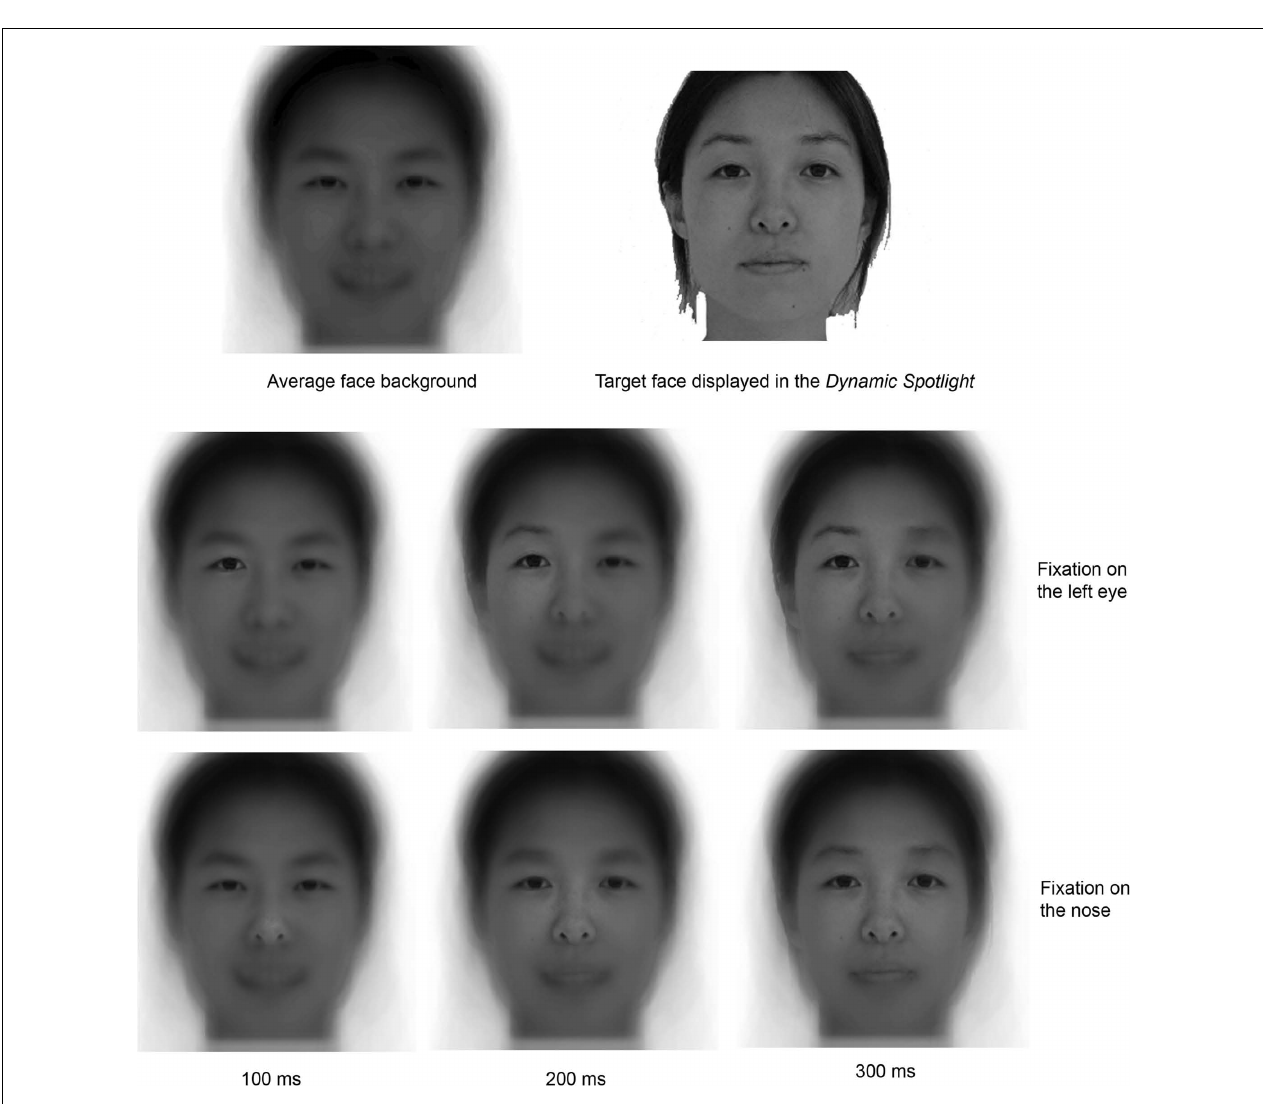
column respectively).The second line illustrates the Expanding Spotlight with a fixation on the left (on the screen) eye; the third line illustrates the Expanding Spotlight with a fixation on the center of the face. Note that there is no direct relationship between the Gaussian aperture size and the availability of information in the full spatial-frequency spectrum.This is due to the overall Gaussian